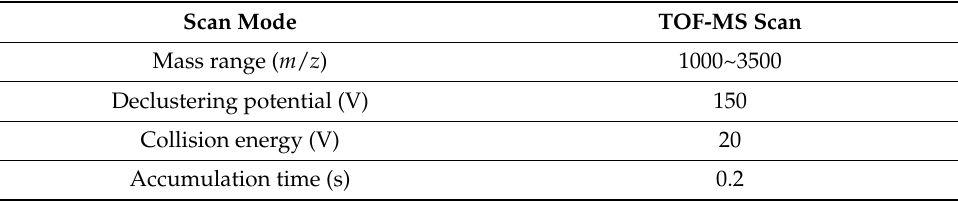
Table 2. The mass spectrometric conditions for intact protein mass